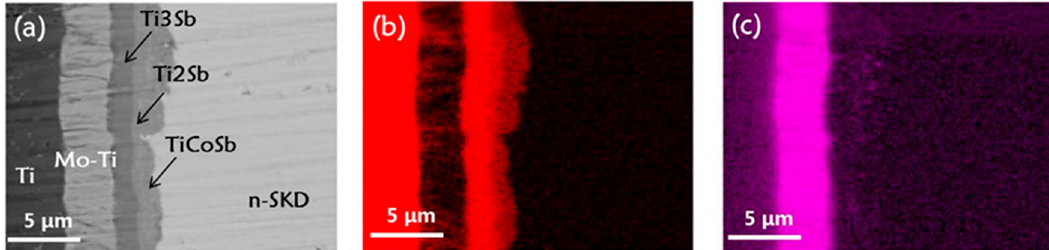
Figure 6. The interfacial microstructure of the pretreated joints isothermally aged at 650 °C for nine days. ( a ) BSE graph and spot testing, ( b ) distribution of Ti, ( c ) distribution of Mo.